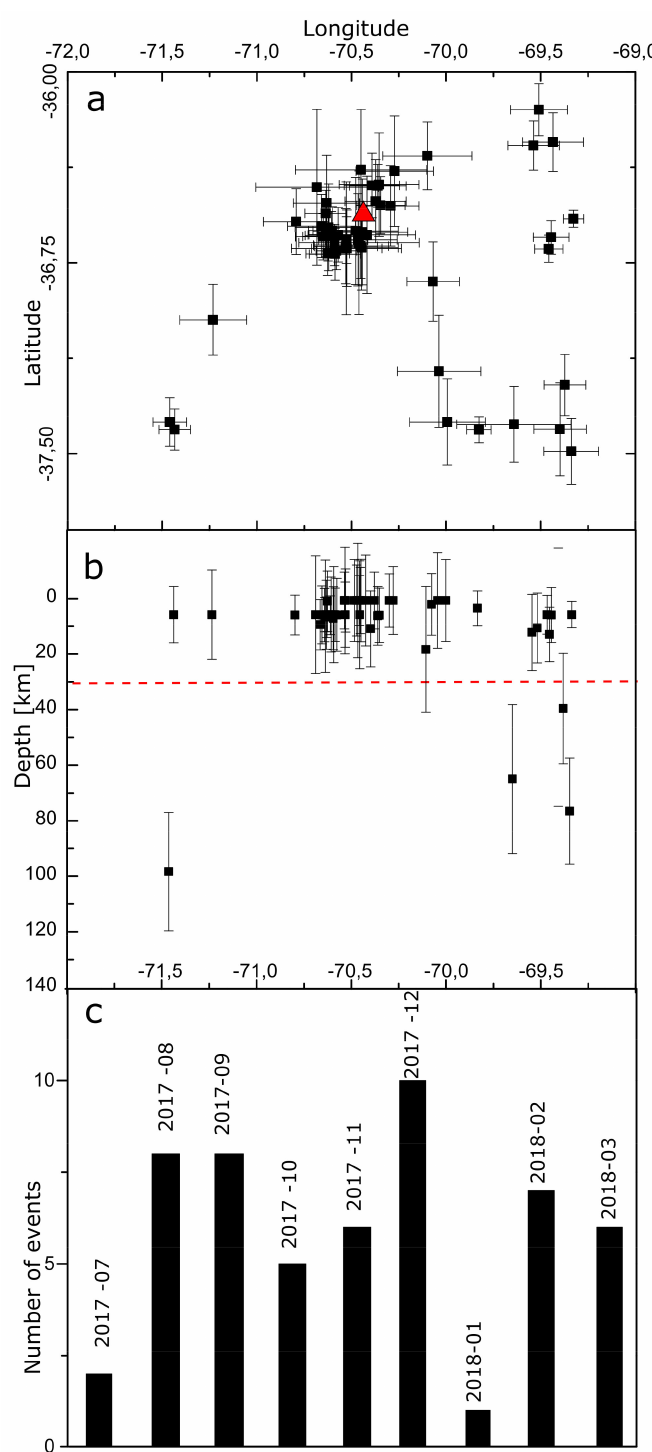
Figure A3. Seismic data. ( a ) Latitude and longitude uncertainties of the seismic events. ( b ) Depth vs. longitude positions. The red line indicates the threshold used for this work. ( c ) Cumulative chart of seismic events per